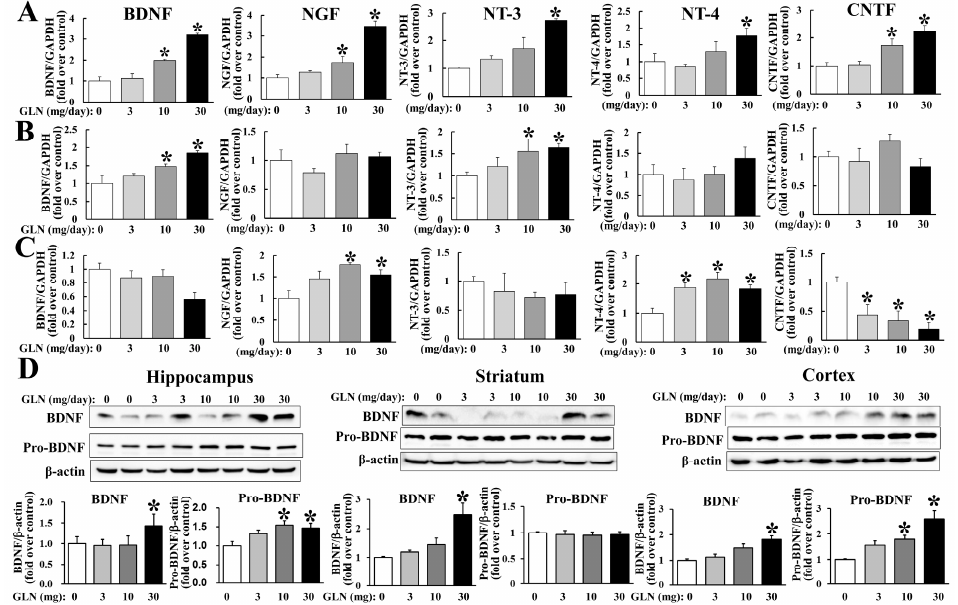
Figure 2. GLN impact on the expression of mRNAs encoding neurotrophins and the BDNF protein in the hippocampus, striatum and cortex. The RNAs were extracted from the hippocampus ( A ), striatum ( B ) and cortex ( C ), followed by the RT-PCR assay to detect the mRNAs of BDNF, NGF, NT-3, NT-4 and CNTF using GAPDH as an internal control. Protein samples were also prepared from the same tissues and the expression of BDNF and pro-BDNF was analyzed by Western blotting with β -actin as an internal control ( D ). The results represent the means ± S.D. ( n = 8) *, p < 0.05, compared with the 0 mg group.